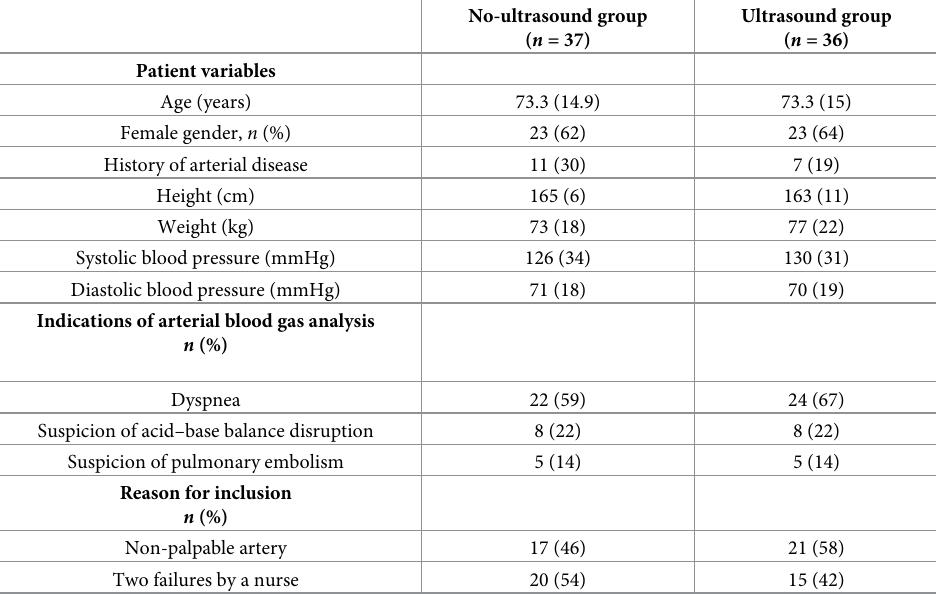
Table 1. Characteristics of the population and reasons for blood gas analysis and for